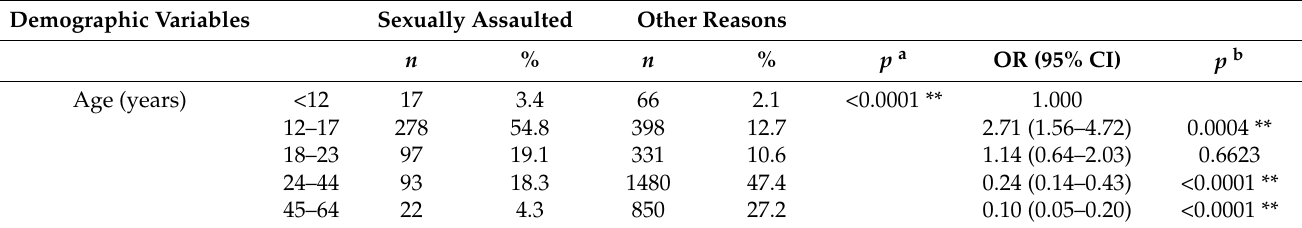
Table 3. Basic demographic data of child and adult female sexual assault victims (by cause).